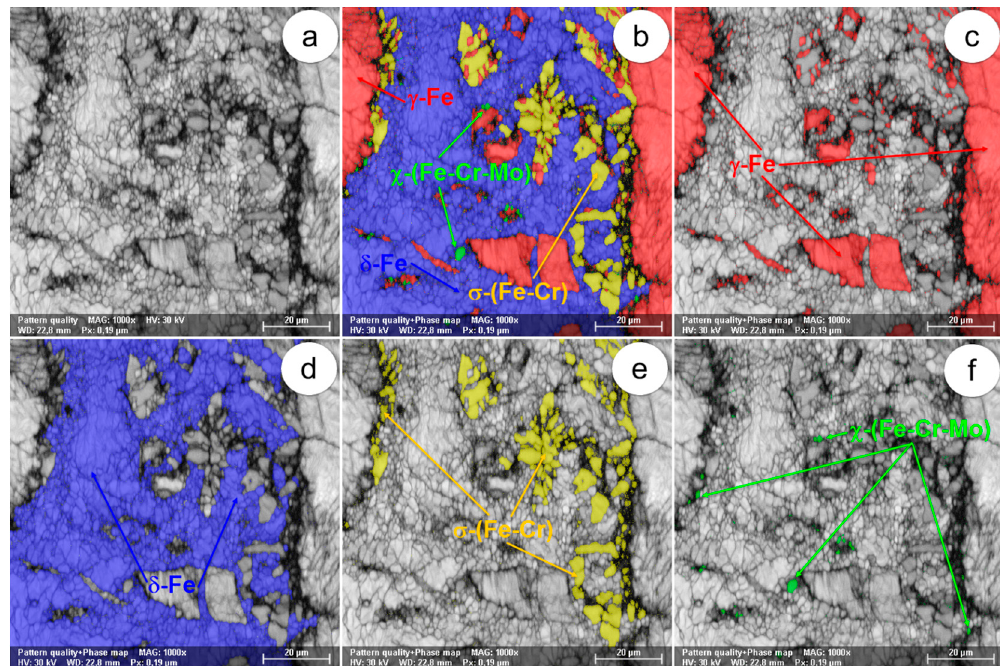
Figure 9. The SEM-EBSD composite images (×1000) obtained after forging at 900 °C: ( a ) the microstructure of the analysed field; ( b ) the distribution of existing phases in the microstructure of the analysed field; ( c ) the distribution of the γ -Fe phase; ( d ) the distribution of the δ -Fe phase; ( e ) the distribution of the σ -(Fe-Cr) phase; ( f ) the distribution of the χ -(Fe-Cr-Mo) phase.